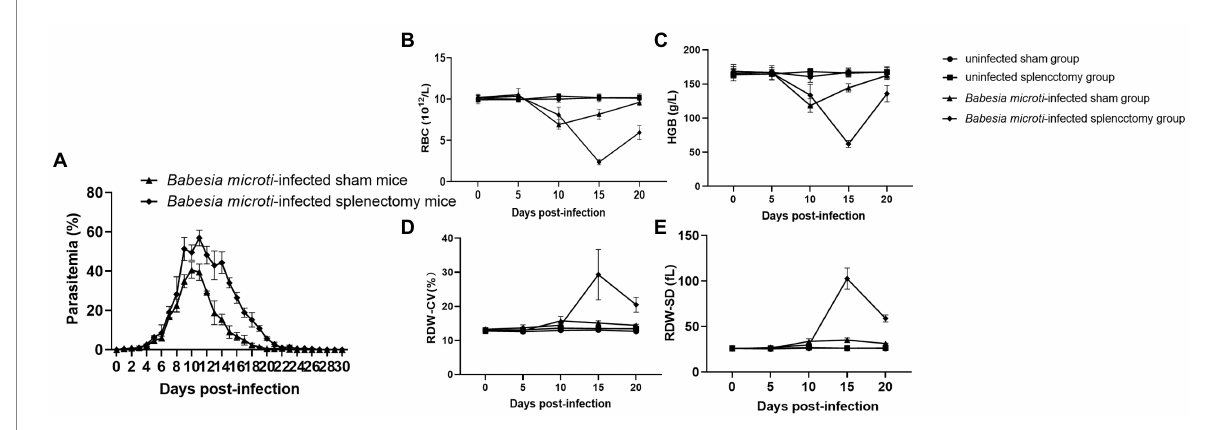
FIGURE 3 Changes in blood parasitemia and parameters after B. microti infection. Line graphs showing (A) the peak parasitemia level of the B. microti - infected splenectomized group was higher than that of the B. microti -infected sham group and persisted for ~6 days, (B) the red blood cell (RBC) count, (C) Hemoglobin concentration (HGB), (D) Red cell distribution width coefficient of variation (RDW-CV), and (E) Red cell distribution width standard deviation (RDW-SD). The results are expressed as the mean ± standard deviation (SD) of five mice.